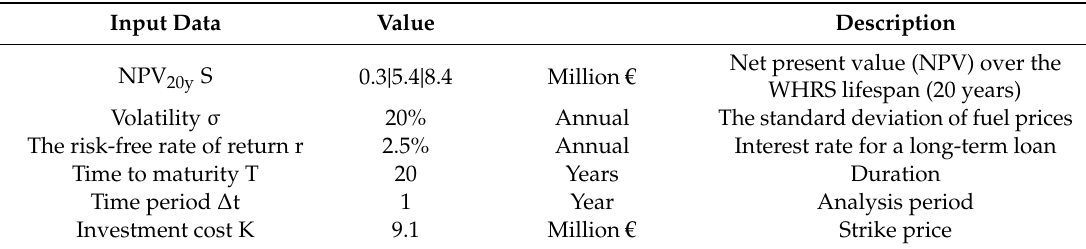
Table 6. Economics Parameters for